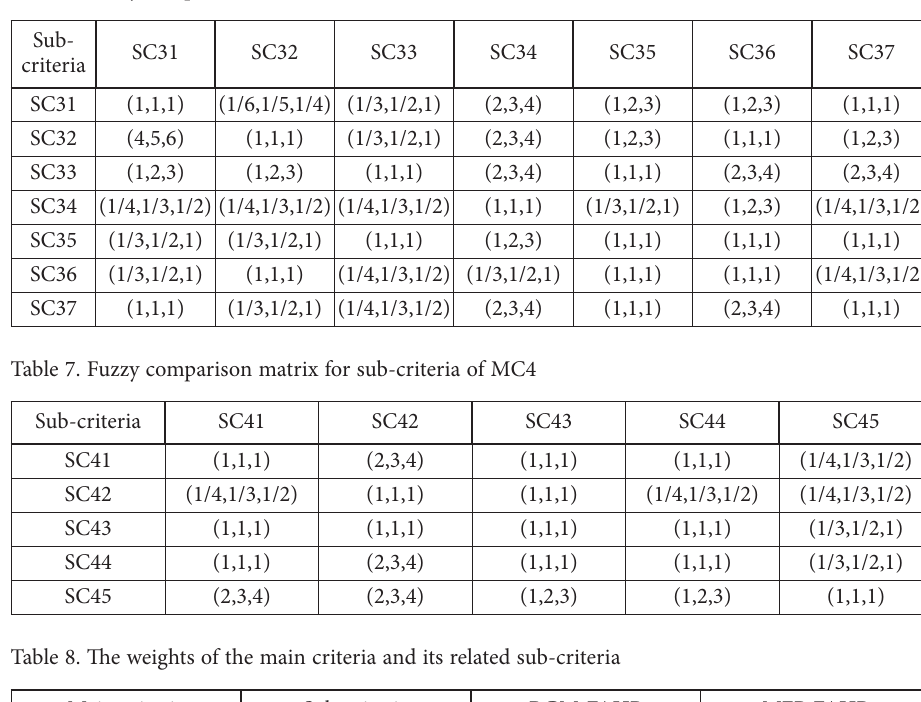
Table 6. Fuzzy comparison matrix for sub-criteria of MC3